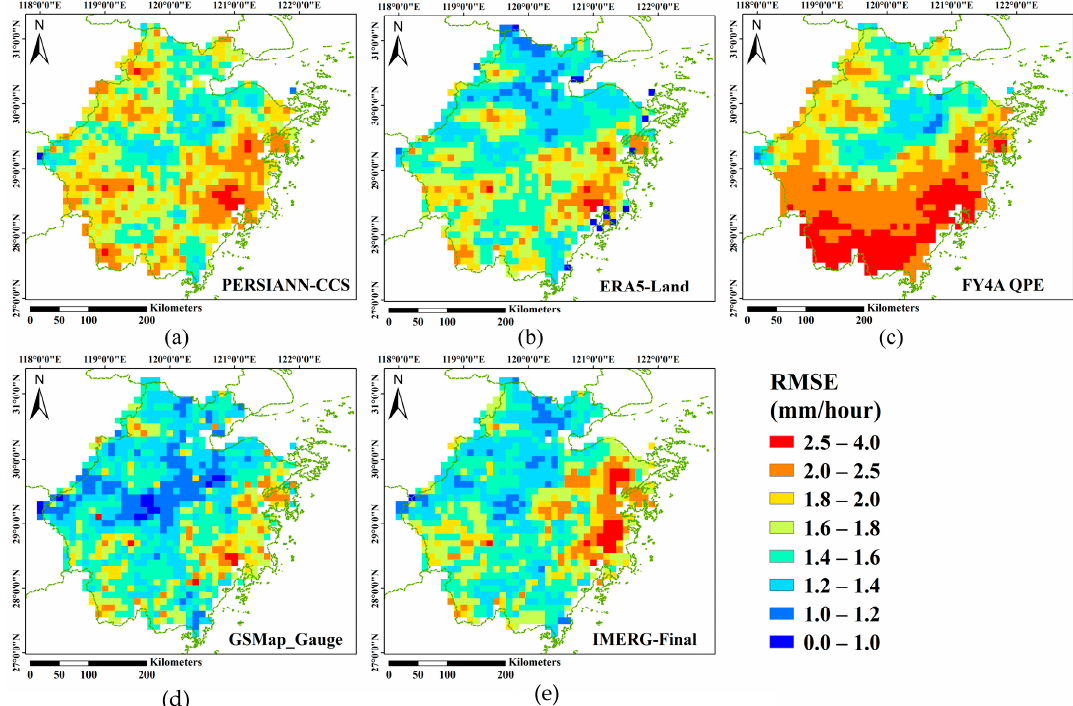
Figure 5. Spatial patterns RMSE based on ( a ) PERSIANN-CCS ( b ) ERA5-Land, ( c ) FY4A QPE ( d ) GSMap_Gauge, and ( e ) IMERG-Final against CMPA, at an hourly scale over the Zhejiang province in summer, from June to August 2019.